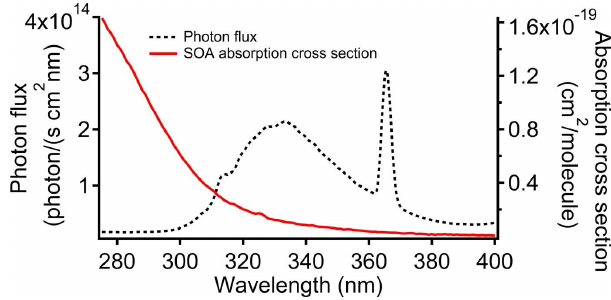
Figure 2. Photon flux (dashed line) inside the glass vessel in the photoreactor and SOA absorption cross section from Wong et al. (2014) (solid